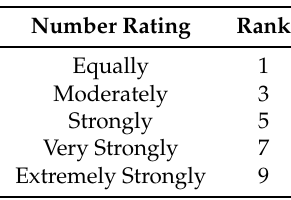
Table 2. A fundamental scale (one to nine). The value of 2, 4, 6, and 8 is considered as the average value between the number before and after them.